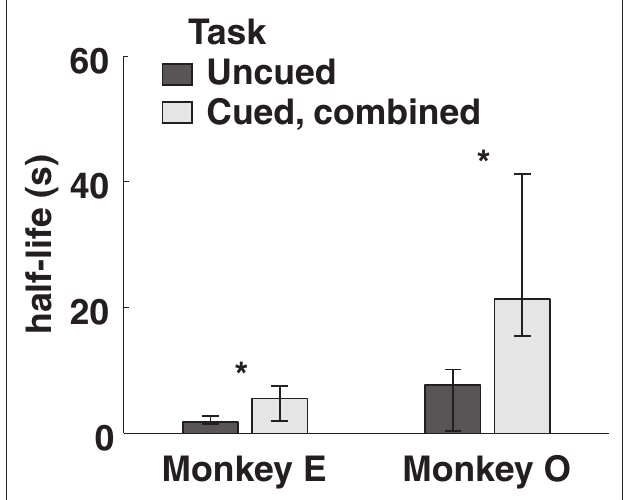
Figure 3 | Model-averaged half-lives for both monkeys, calculated using only trials with total length 6.5 s. Cued, combined refers to data pooled across the two cued conditions for each subject. Error bars represent 95% confidence intervals for the means, calculated by bootstrap resampling.